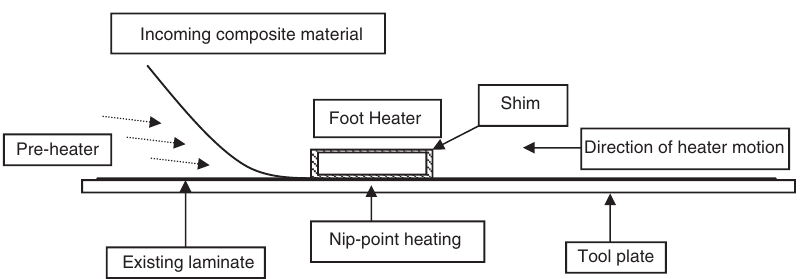
Figure 1 Components of thermal model